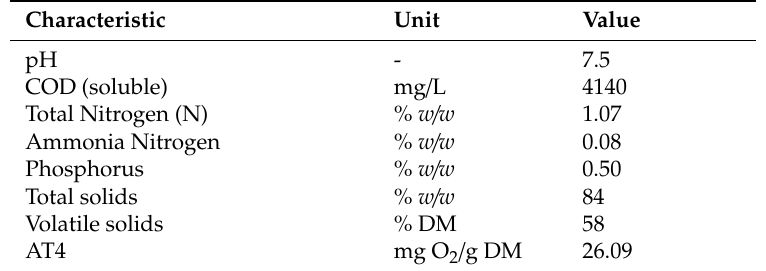
Table 1. Characteristics of organic remaining fraction (ORF) after autoclaving, fraction < 10